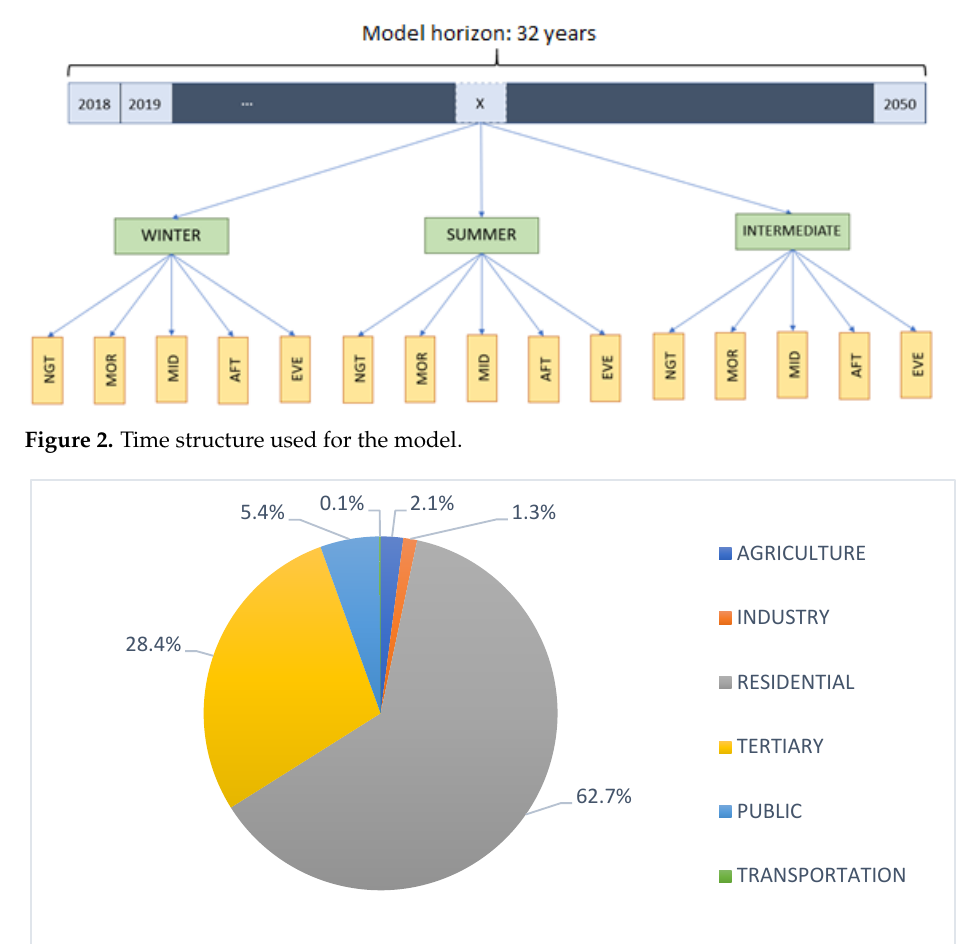
Figure 1. Comparison between the annual average clear-sky solar irradiance and the residential load curve on a daily basis, both normalized. (The residential curve was normalized with respect to the peak demand; the mean annual global clear-sky irradiance was normalized with respect to the peak irradiance value.)